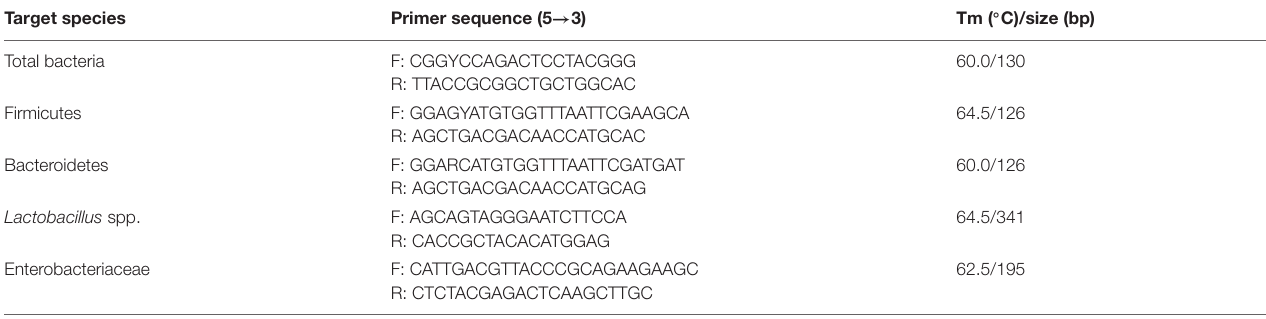
TABLE 3 | Primer information on the microflora for qPCR.